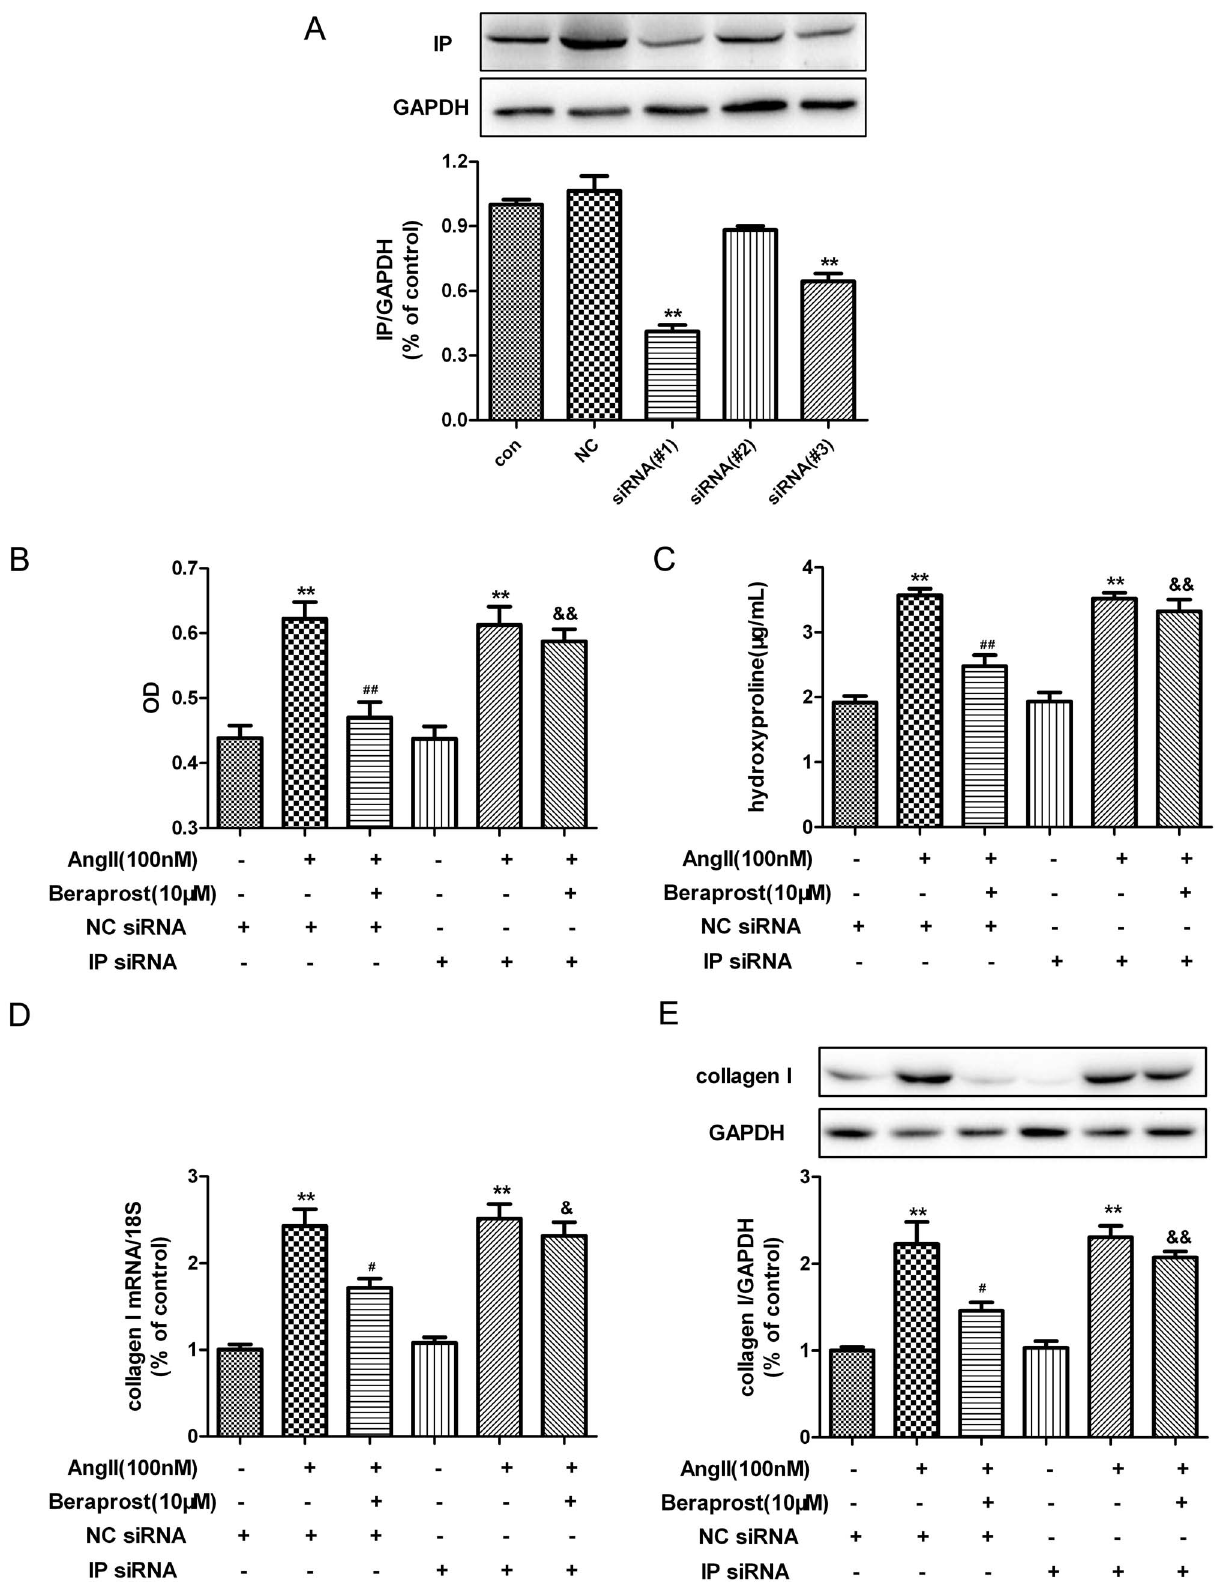
Figure 3. Prostacyclin receptor (IP) contributes to beraprost-mediated attenuating effect on cardiac fibroblast proliferation and collagen I synthesis. (A) Neonatal rat cardiac fibroblasts were serum deprived for 4 h and then transfected with IP-specific siRNA (siRNA # 1, siRNA # 2 or siRNA # 3) or nonspecific control siRNA (NC siRNA) for 24 h. Cell lysates were tested for IP expression by western blot. Cells treated with